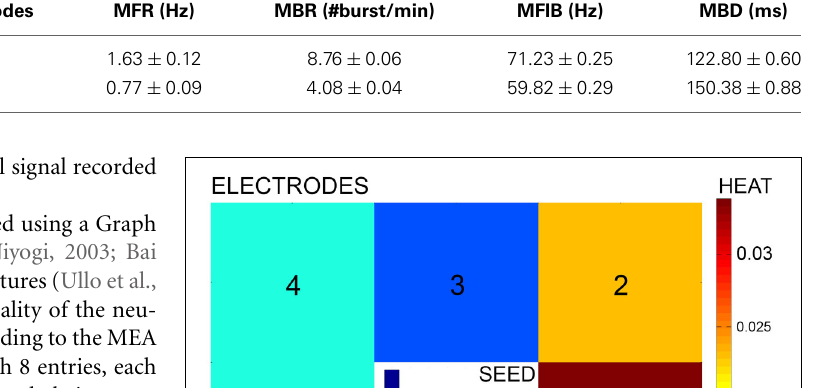
Table 1 | HD-MEA dataset description. Dataset